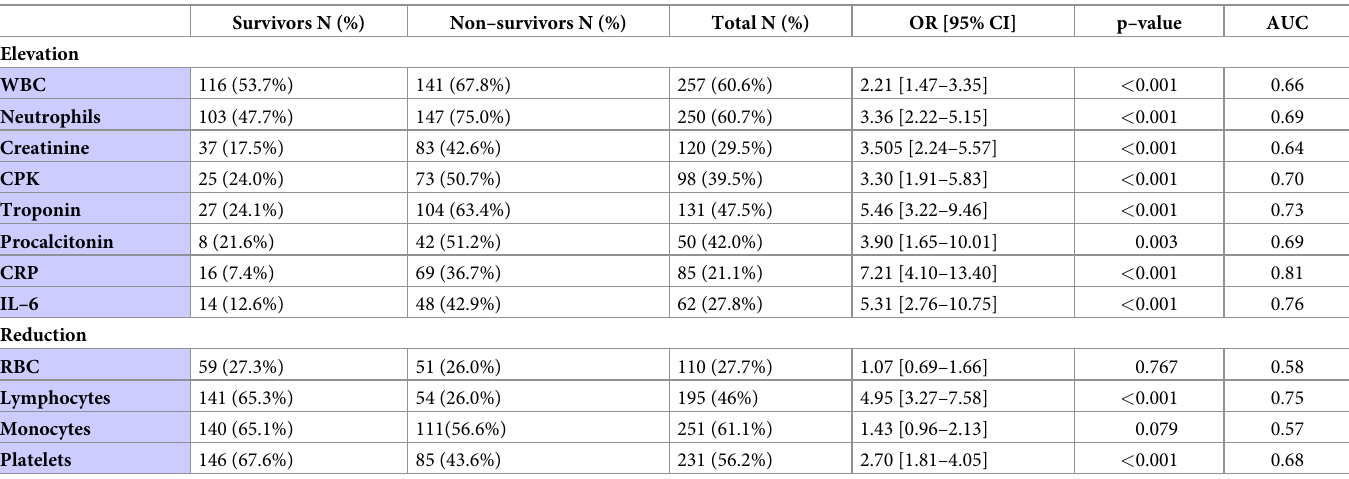
Table 6. Comparison of labs results between alive and death groups.